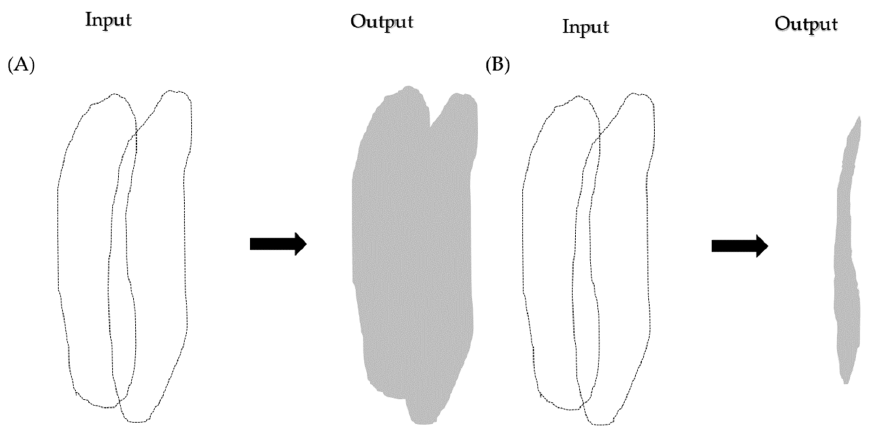
Figure 4. ( A ) Example of a union with features within a feature class that overlaps. ( B ) Example of an intersection with a feature within a feature class that overlaps.